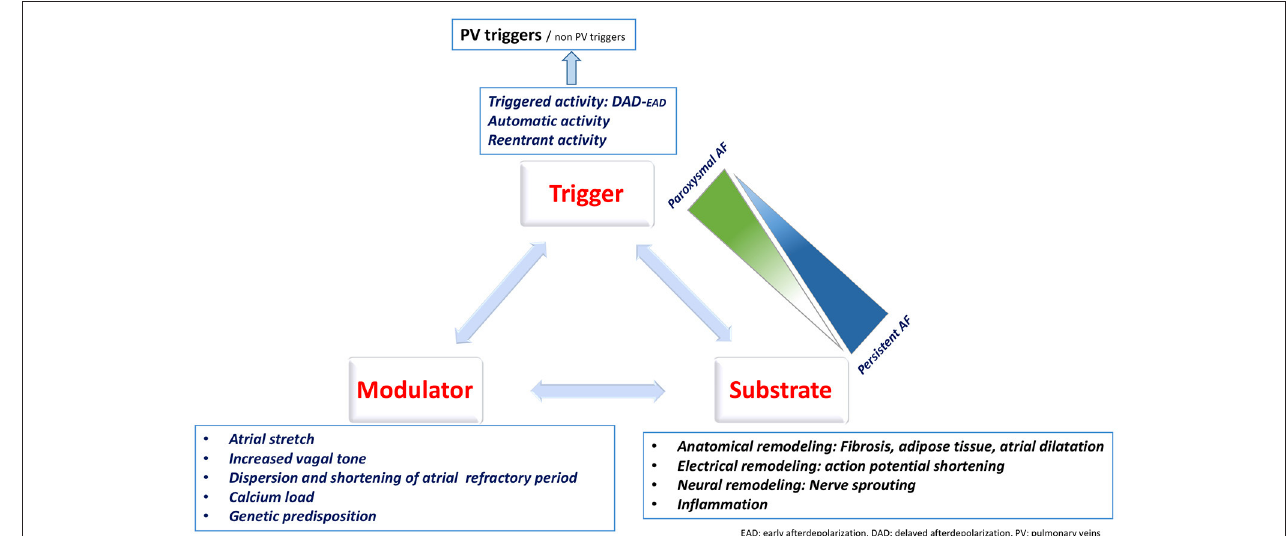
FIGURE 1 | Coumel triangle summarizing the different contributors to AF.